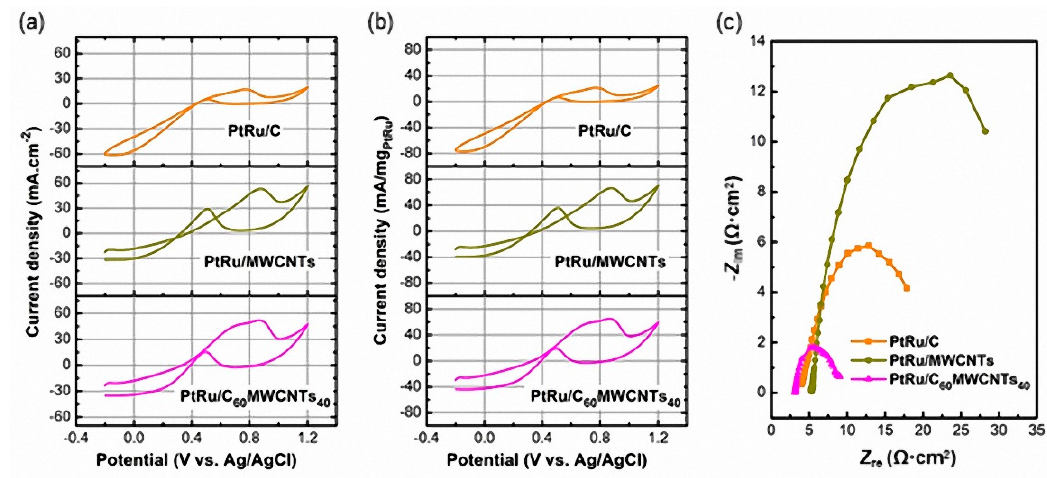
Figure 3. ( a , b ) Cyclic voltammograms (CV) of PtRu/C, PtRu/MWCNTs, and PtRu/C 60 MWCNTs 40 with current density units of mA · cm − 2 and mA/mg PtRu . ( c ) EIS Nyquist plots of the samples in a frequency range from 0.1 Hz to 100 kHz. The electrolyte was a mixture solution of 0.5 M H 2 SO 4 and 1.0 M CH 3 OH. Table 2. Electrochemical parameters of PtRu/C, PtRu/MWCNTs, and PtRu/C 60 MWCNTs 40 . Sample